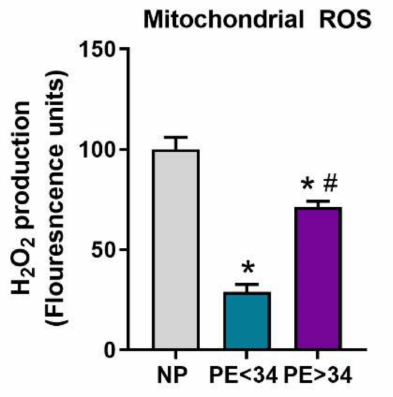
Figure 5. Mitochondrial ROS in isolated placental mitochondria. Amplex Red assay showed mi- tochondria from preeclamptic patients of both gestational ages (PE < 34 weeks, n = 4; teal bar and PE > 34 weeks, n = 5; purple bar) exhibit reduced H 2 O 2 production vs. normal pregnant (NP, n = 5; gray bar). Further, H 2 O 2 was found to be significantly lower in preeclamptic patients of early gestational age (PE < 34 weeks, n = 4) vs. preeclamptic patients of late gestational age (PE > 34 weeks, n = 5). The results represent means ± SEM. * p < 0.05 vs. NP, # p < 0.05 vs. PE < 34. H 2 O 2, hydrogen peroxide; ROS, reactive oxygen species, SEM, standard error of